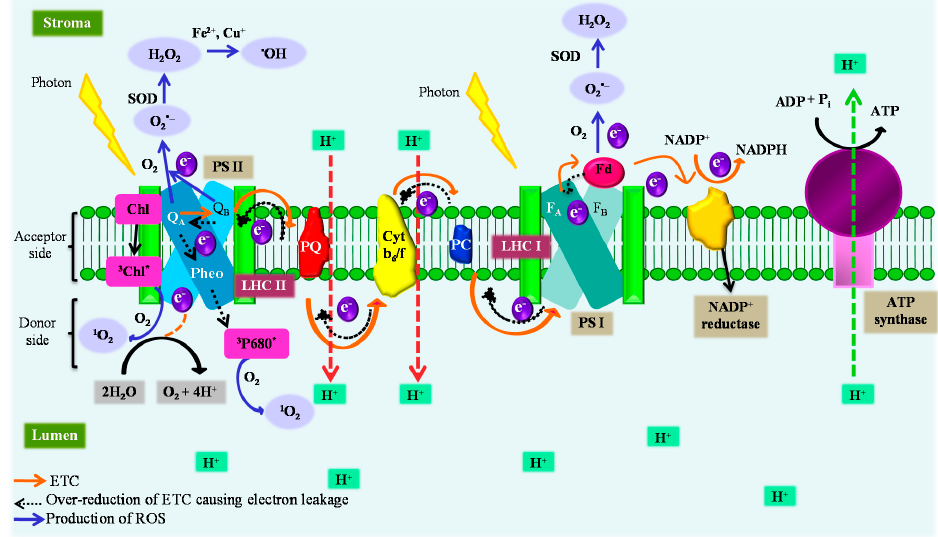
Figure 3. Photosynthetic electron transport chain under abiotic stress gets over-reduced and triggers the production of ROS. Photons striking at light-harvesting complex I and II (LHC I and II) result in electron (e − ) generation and hydrogen or proton (H + ) gradient, which initiates the electron transport chain (ETC) at photosystem (PS) I and II (through photolysis of H 2 O) and production of NADPH and ATP by NADPH reductase and ATP synthase, respectively. However, the excess illumination of photons at LHC II converts the chlorophyll (Chl) molecule into an excited triplet form ( 3 Chl*), which reduces O 2 to 1 O 2 . The reduced activity of Calvin’s cycle due to low CO 2 , leads to the over-reduction of ETC causing electron leakage. The electron moves in reverse from PS I to II and at PS II from Q B to Q A and then to the pheophytin forming an excited triplet chlorophyll ( 3 P680), which reduces O 2 to 1 O 2 . Over-reduction of Q B and Q A also directly reduces O 2 to O 2 • – . At PS I, the over-reduction of ETC prompts electron leakage from ferredoxin (Fd) to O 2 forming O 2 • – via Mehler’s reaction. The O 2 • – generated is dis-mutated either spontaneously or by the action of superoxide dismutase (SOD) to H 2 O 2 , which in the presence of reduced redox metals (Fe 2+ , Cu + ) changed to a highly toxic • OH.